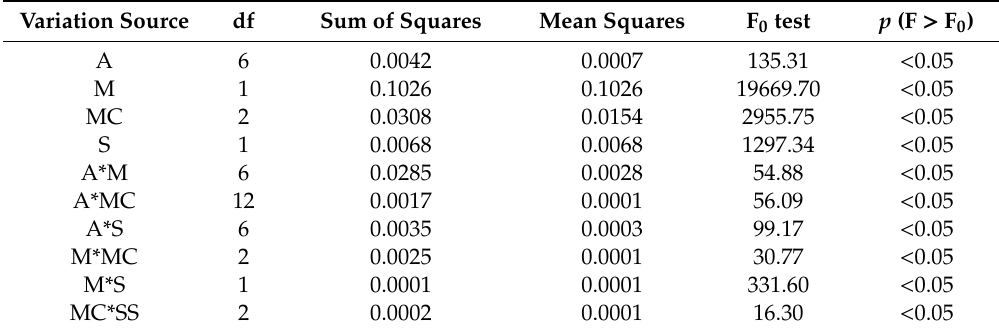
Table 3. Statistical analysis of the e ff ect of variation source and its interactions on starch-based foams specific energy consumption (SME) during